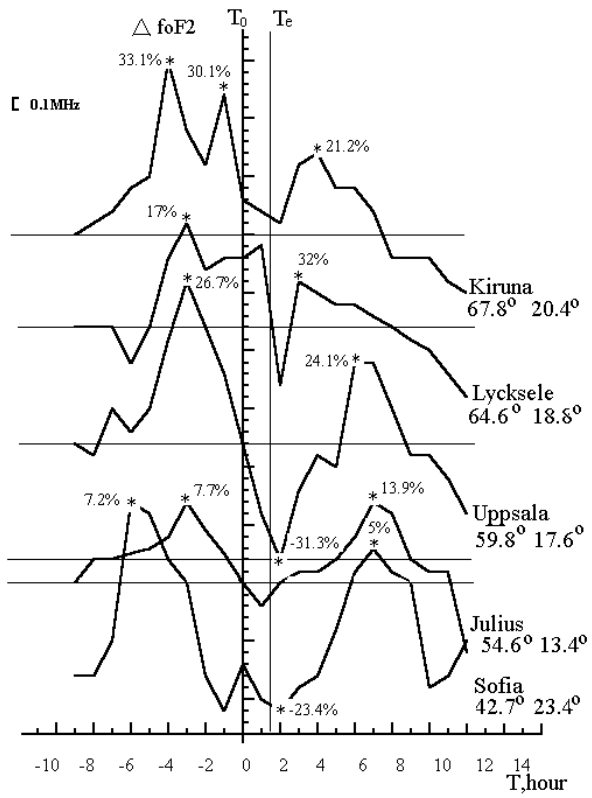
Fig. 6. The variations of 1 fo F2 values for the negative substorm that occurred on 27 March 1999 ( T o = 22:00UT or 00:00LT, I = − 110nT, τ = 1 . 5h) through the first (northern) longitudinal chain of stations of the IDCE, LT = UT + 2. The vertical lines mark substorm onset, T o , and the end of the substorm, T e . Asterisks are δ fo F2 (%) values.